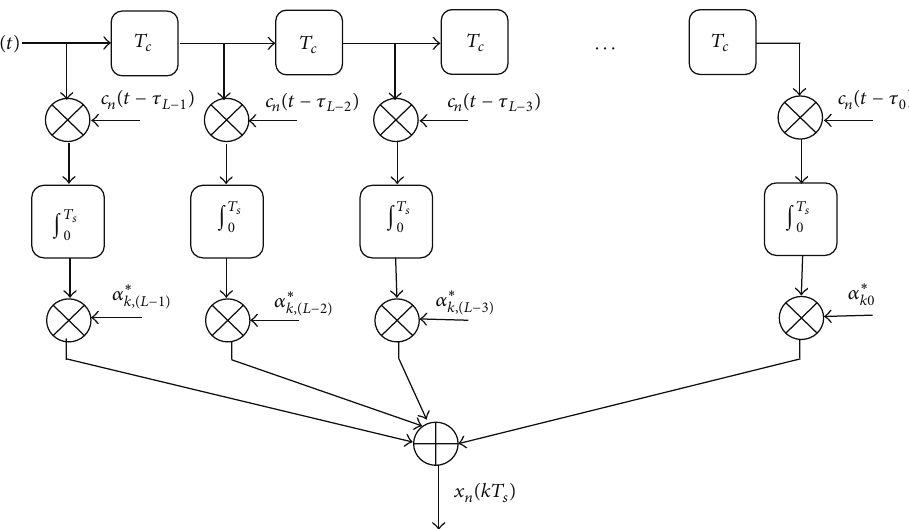
Figure 5: The 𝑛 th 𝐿 -fingers RAKE